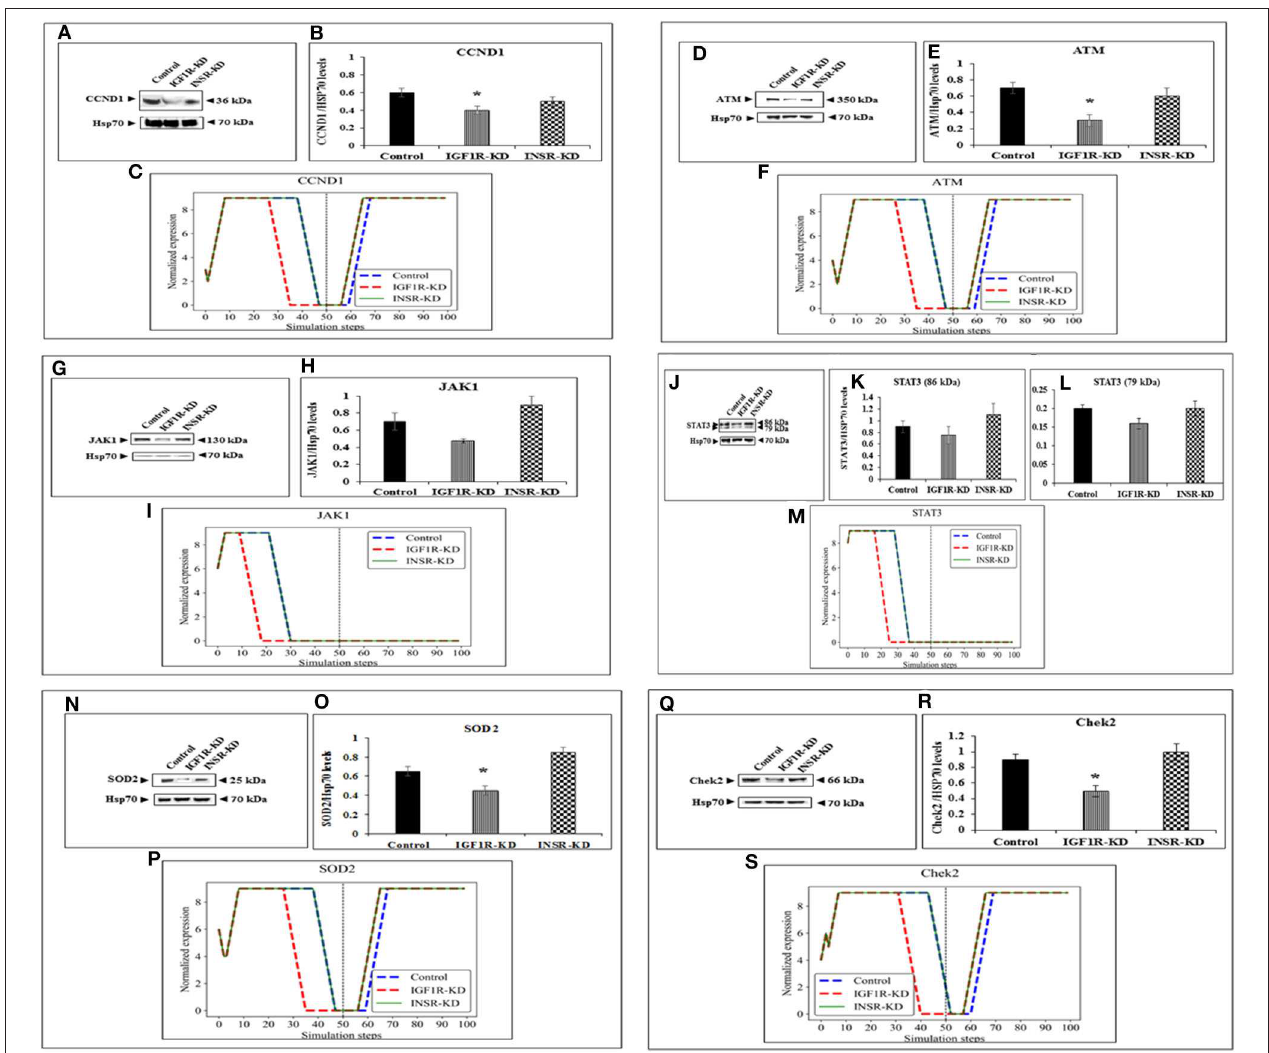
FIGURE 5 | Six selected genes exhibiting a change between control and IGF1R-KD, validated by Western blots. Western blot analysis showing expression of CCND1 (A) , ATM (D) , JAK1 (G) , STAT3 (J) , SOD2 (N) , and Chek2 (Q) proteins levels were performed as described above. (B,E,H,K,L,O,R) Scanning densitometry analysis of basal proteins levels. Bars represent protein values (AU, arbitrary units), normalized to the corresponding Hsp70 levels. Results of an illustrative experiment, repeated twice with similar results, are shown. * p < 0.01 vs. control cells. (C,F,I,M,P,S) BioNSi simulation plots of normalized expression values against 100 simulation steps are shown. Control (blue), IGF1R-KD (red), and INSR-KD (green). A dashed vertical line indicates 50 steps of simulation. Splicing has occurred in the blot figures and full scans of the entire original (unprocessed) gels are presented in Supplementary Material . Squares in the uncropped films denote bands shown in the final